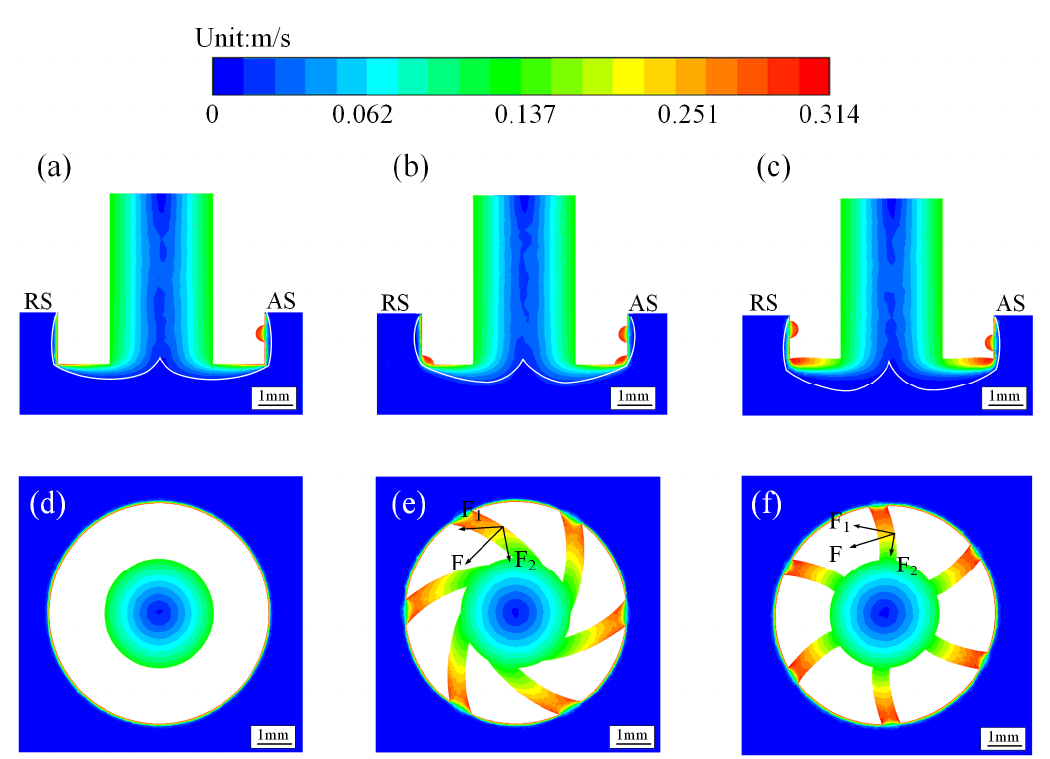
Figure 3. Material flow contours of a cross section with ( a ) RN sleeve, ( b ) RF sleeve and ( c ) RE sleeve; flow contours 1.6 mm from the plate bottom with ( d ) RN sleeve, ( e ) RF sleeve and ( f ) RE sleeve.